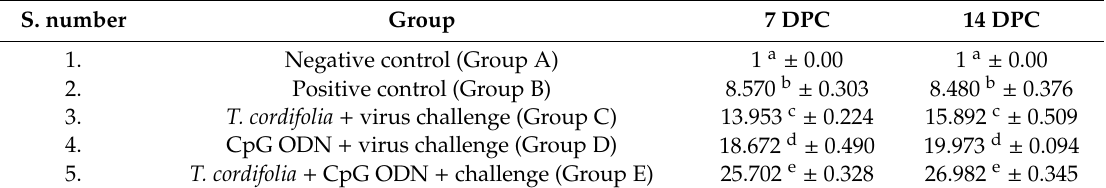
Table 4. Quantitative real time PCR analysis of IFN- γ expression in PBMCs of chickens challenged with vvIBDV at di ff erent DPC.